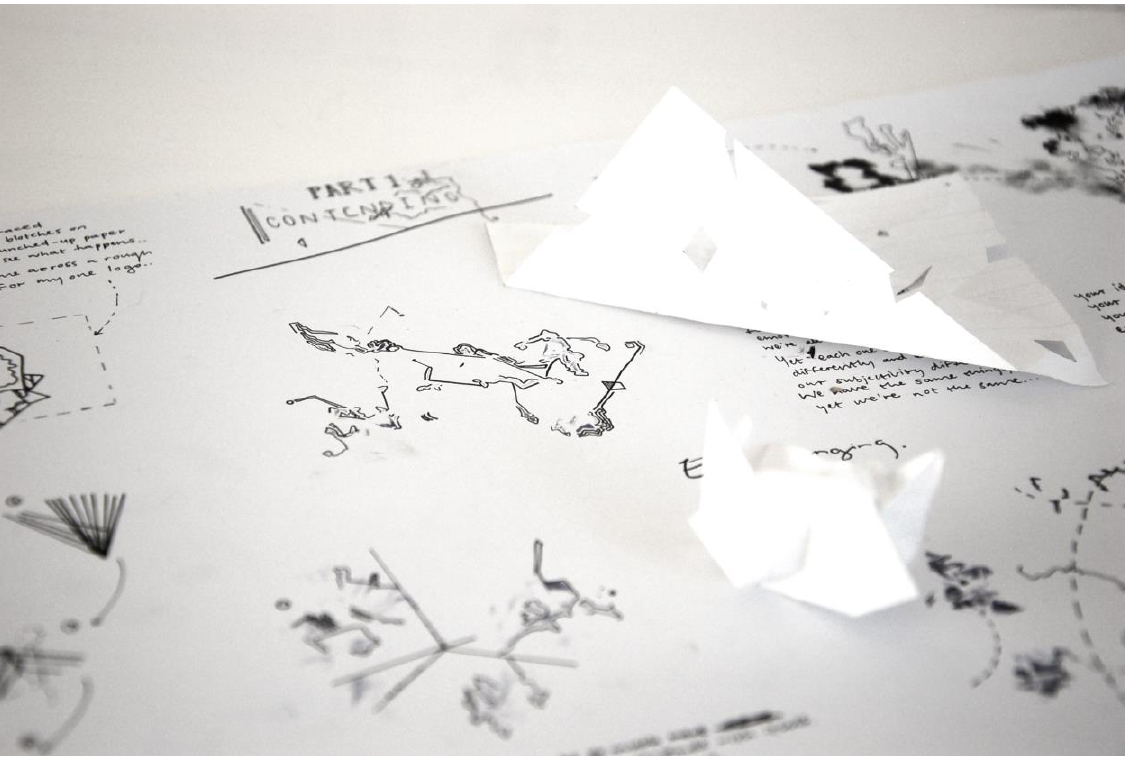
Figure 1.1 : Project 2: Process development (representing identity and subjectivity through paper folding and visual mark making) (Source: Julie,